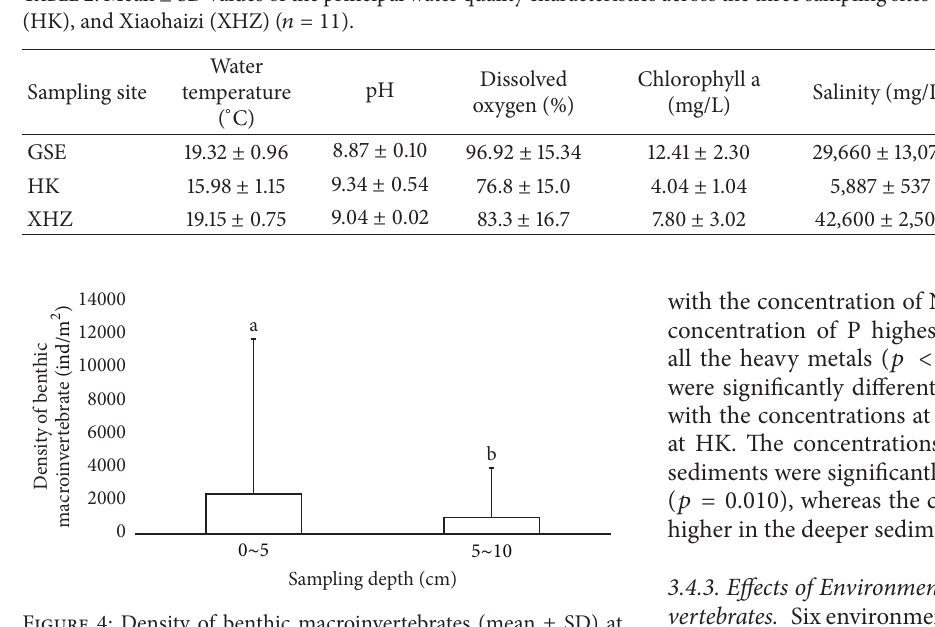
Figure 4: Density of benthic macroinvertebrates (mean ± SD) at sediment depths of 0–5 and 5–10 cm ( 𝑛 = 66 ).